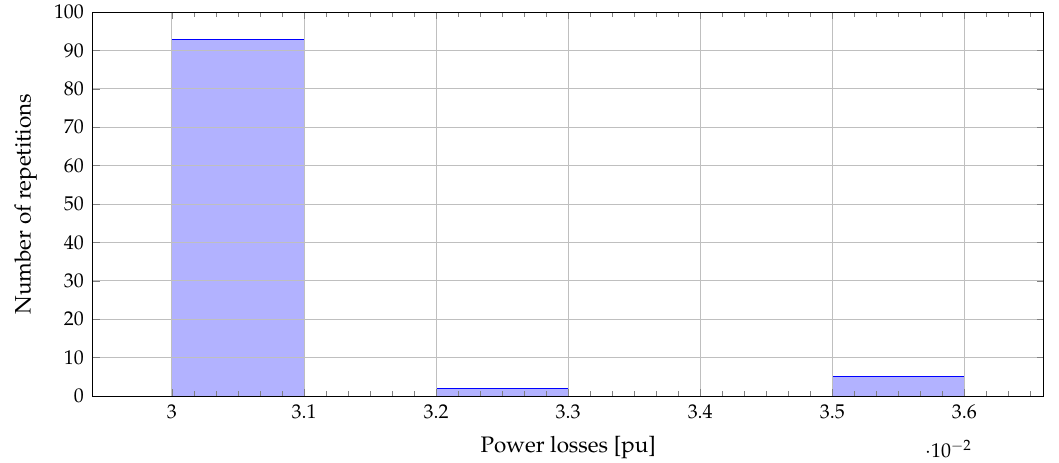
Figure 3. Behavior of the proposed hybrid GA-PSO after 100 consecutive evaluations in the 21-node test feeder.